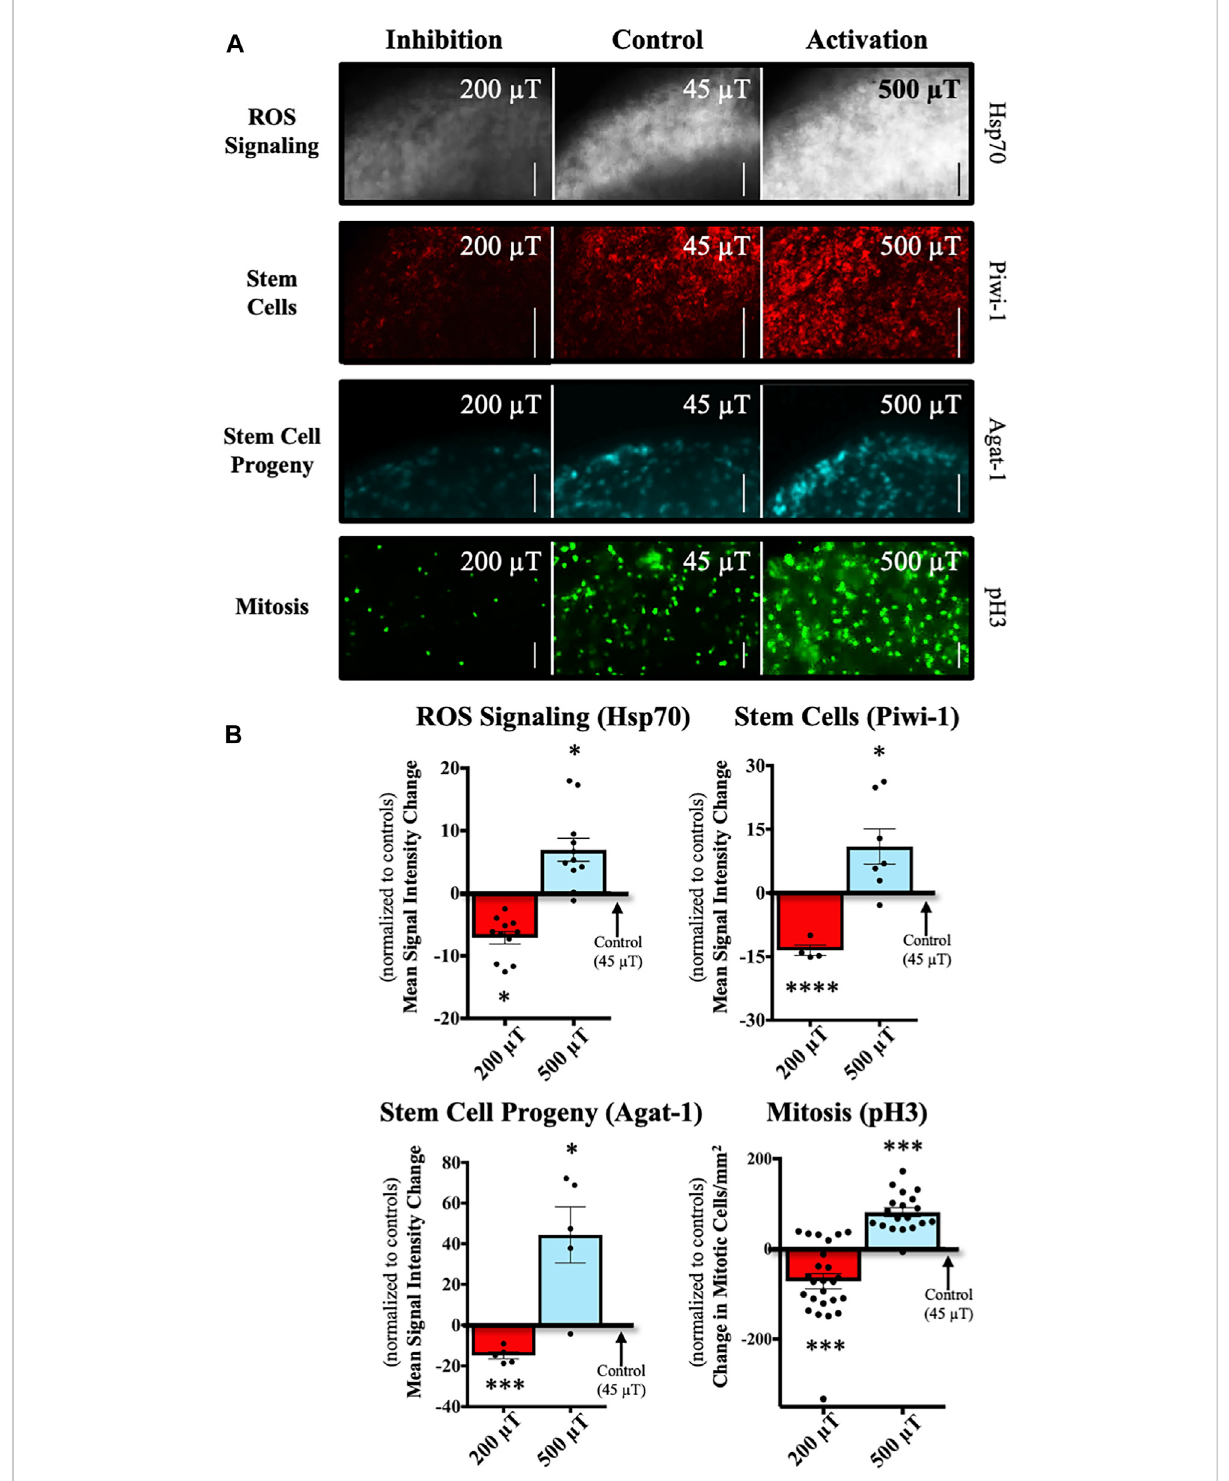
FIGURE 4 WMFs Predictably Manipulate ROS-Mediated Stem Cell Behavior. WMF effects (at the anterior wound site) from 200 µT or 500 µT exposure, as compared to 45 µT controls. (A) Representative images ofstem cell markers and proliferation. Expression of heat shock protein70 (Hsp70) at3 days after injury (grayscale panels), a marker of ROS signaling during planarian regeneration. Piwi-1 expression at 3 days (red panels), a general marker of stem cells. Agat-1 expression at 3 days (cyan panels), a marker of late stem cell progeny (descendants). Actively dividing stem cells (mitosis) at